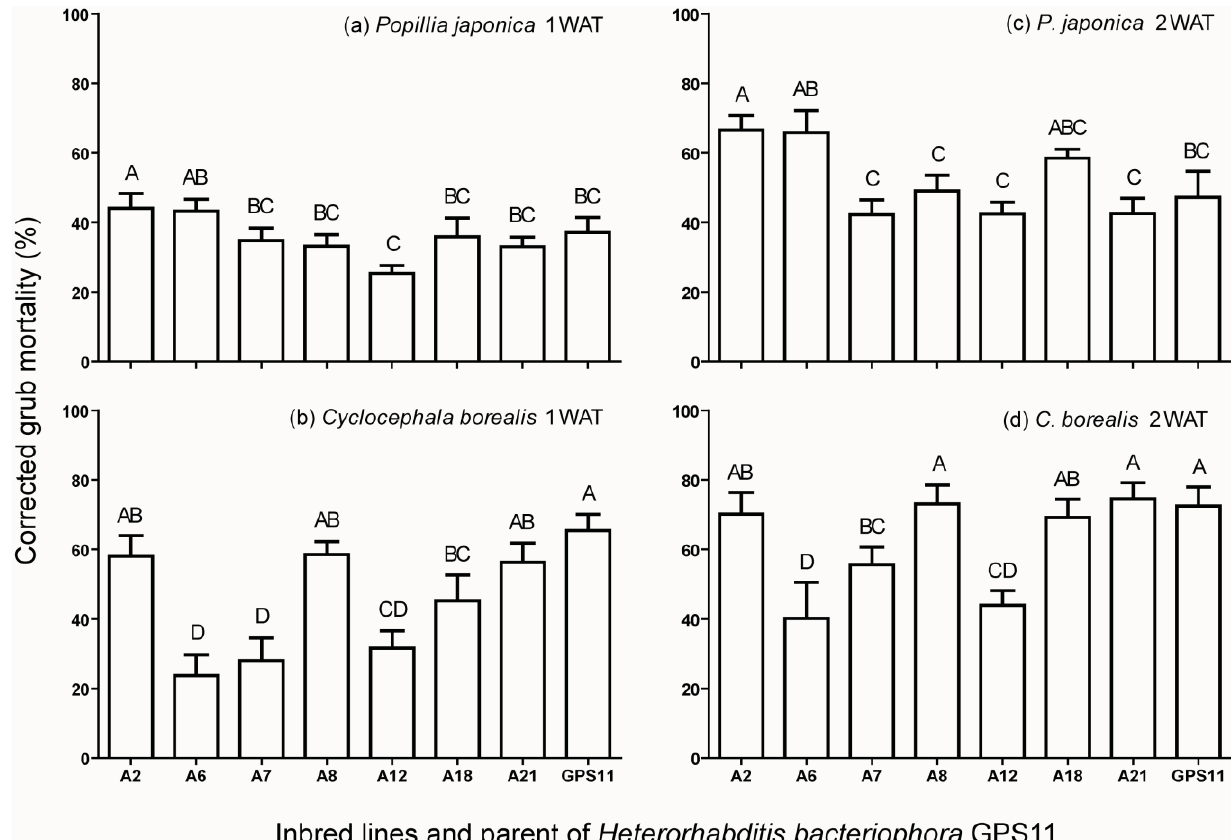
Figure 1. Mean percentage mortality of Popillia japonica and Cyclocephala borealis grubs caused by inbred lines and parent of H. bacteriophora GPS11 strain 1 and 2 weeks after treatment (WAT). Bars (mean ± SEM) with same letter(s) are not significantly different according to P < 0.05 (Tukey’s HSD test)